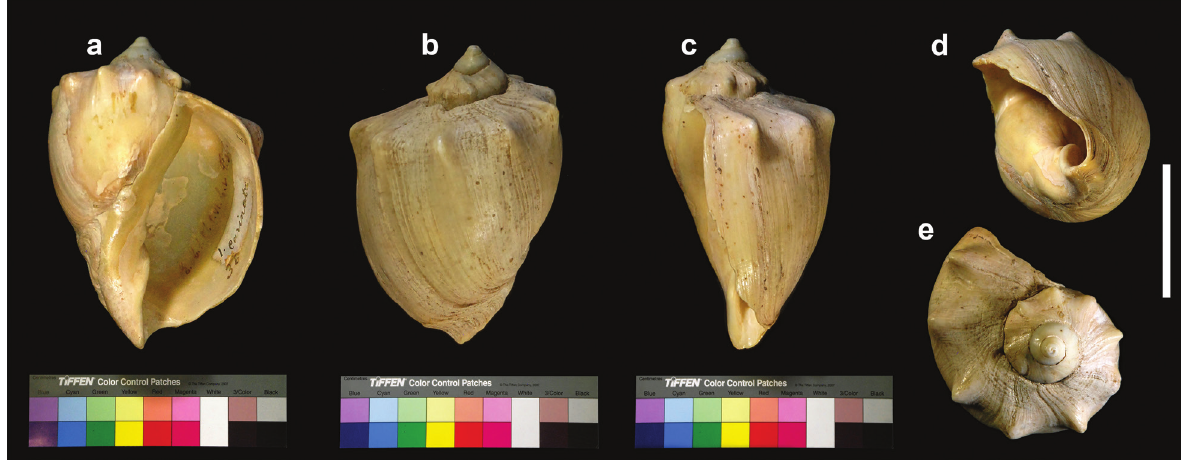
Figure 30. Holotype of Voluta colocynthis carinata , figured by Lahille (1895: pl. V, fig. 36) a Apertural view b Dorsal view c Lateral view d Umbilical view e Apical view. Scale bar: 5 cm.